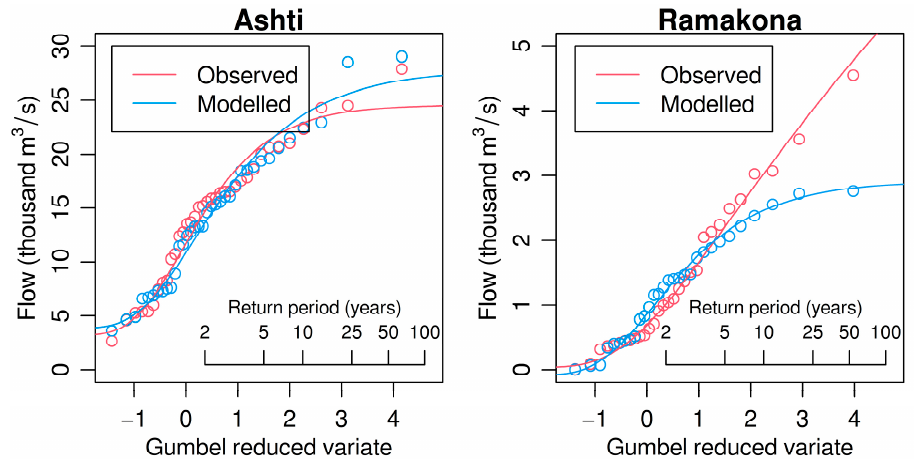
Figure 8. Observed and modeled flood frequency curves for Ashti and Ramakona (PDM optimized for AMAX only).